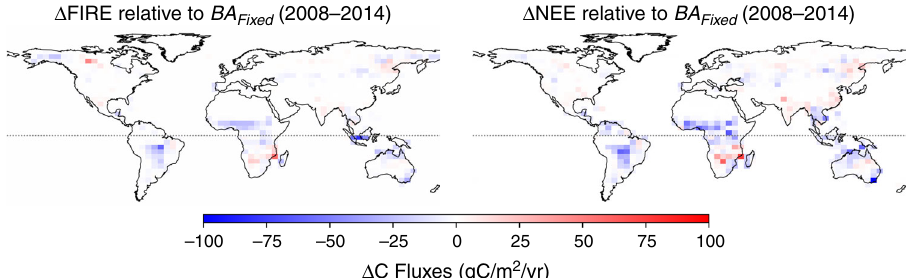
Fig. 5 Distribution of differences in fi re and NEE fl uxes between scenarios. Differences in the CARDAMOM simulated fi re and NEE fl uxes between the Observed BA and the Fixed BA scenarios averaged between 2008 and